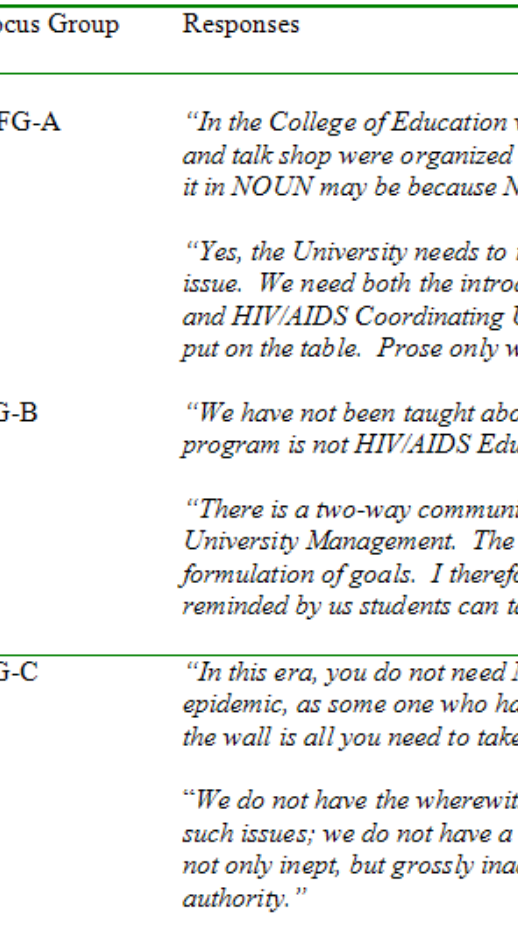
Table 7. Focus Group